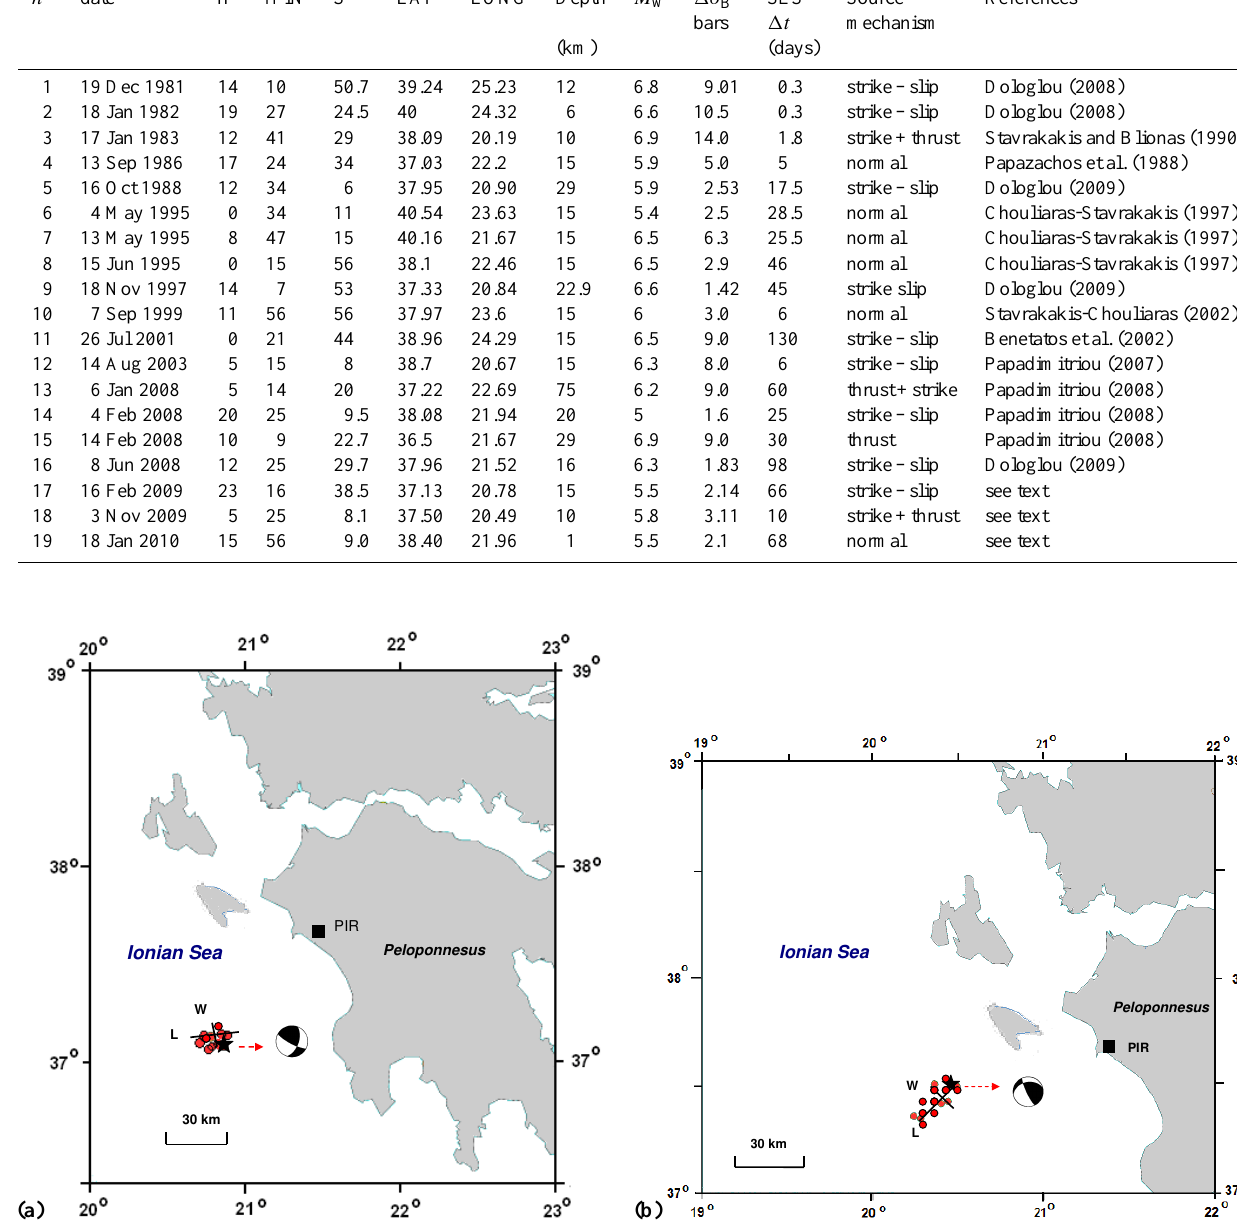
Fig. 1. Map of Western Greece, with the distribution (forming a cluster) of all reported by USGS or EMSC aftershocks with M w ≥ 3 (red Fig.1a solid circles). (a) For event no. 17 (16 February 2009) for the period 16 February 2009 (23:17) to 30 March 2009. (b) For event no. 18 (3 November 2009) for the period 3 November 2009 (05:26) to 31 December 2009 and (c) for event no. 19 (18 January 2010) for the period 18 January 2010 (15:57) to 28 February 2010. The epicentres of the corresponding main shocks are presented by stars and their focal mechanisms by a lower hemisphere projection with black and white quadrants for compression and dilatation, respectively (beach ball). Representative aftershock areas of length L and width W for all cases are marked. Black squares denote the position of the SES stations that recorded the associated precursory